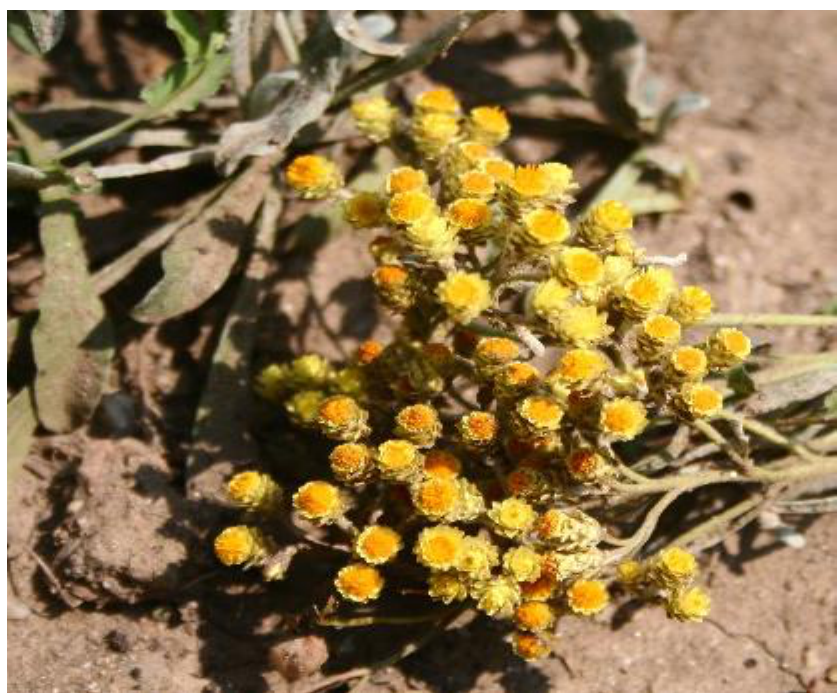
Figure 2. Helichrysum arenarium plants in the stage of full flowering inflorescence (August 2013) at the “Dimitrie Br â ndz ă ” Botanical Garden of the University of Bucharest, Romania (used with permission from Ref.